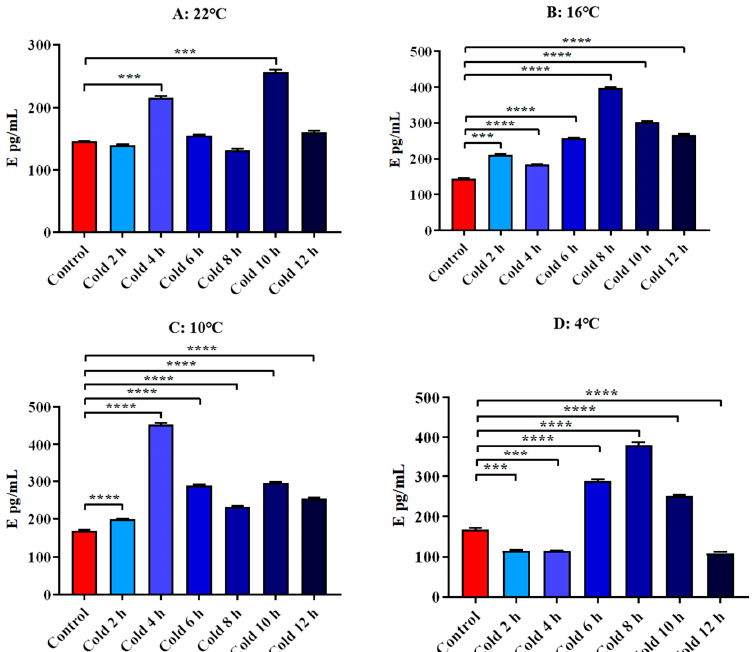
Figure 10. Changes in serum E of ICR mice under different intensity of cold exposure. ( A ). Changes in the serum E of mice under cold exposure at 22 ◦ C; ( B ). Changes in serum E of mice under cold exposure at 16 ◦ C; ( C ). Changes in the serum E of mice under cold exposure at 10 ◦ C; ( D ). Change in the serum E of mice under cold exposure at 4 ◦ C. Compared with 28 ◦ C normal temperature control group, the difference was significant as *** p < 0.001. **** p < 0.0001. The level of NE in all time points was significantly increased at 22 ℃ . It was signifi- cantly increased at 4 h, 6 h, 8 h and 12 h after cold exposure at 16 ℃ ( p < 0.0001). And it decreased significantly for 2 h ( p < 0.001). After cold exposure at 10 ℃ , all time points were significantly increased ( p < 0.0001). After 4 ℃ cold exposure for 4 h, 6 h, 8 h and 10 h, it increased significantly ( p < 0.001). And it decreased significantly for 2 h and 12 h ( p < 0.0001). All these results are shown in Figure 11.